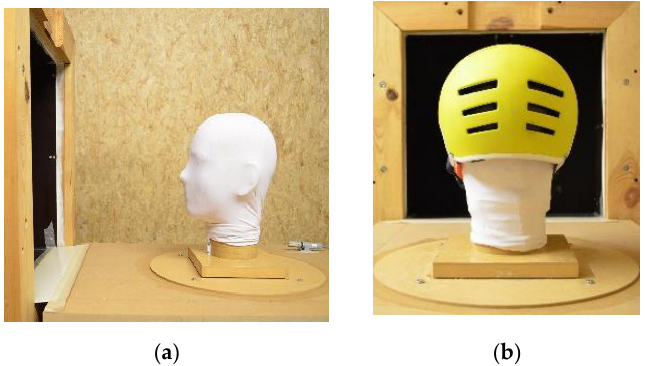
Figure 3. ( a ) Manikin head with skin suit at wind-tunnel exit; ( b ) thermal manikin with skin suit and helmet